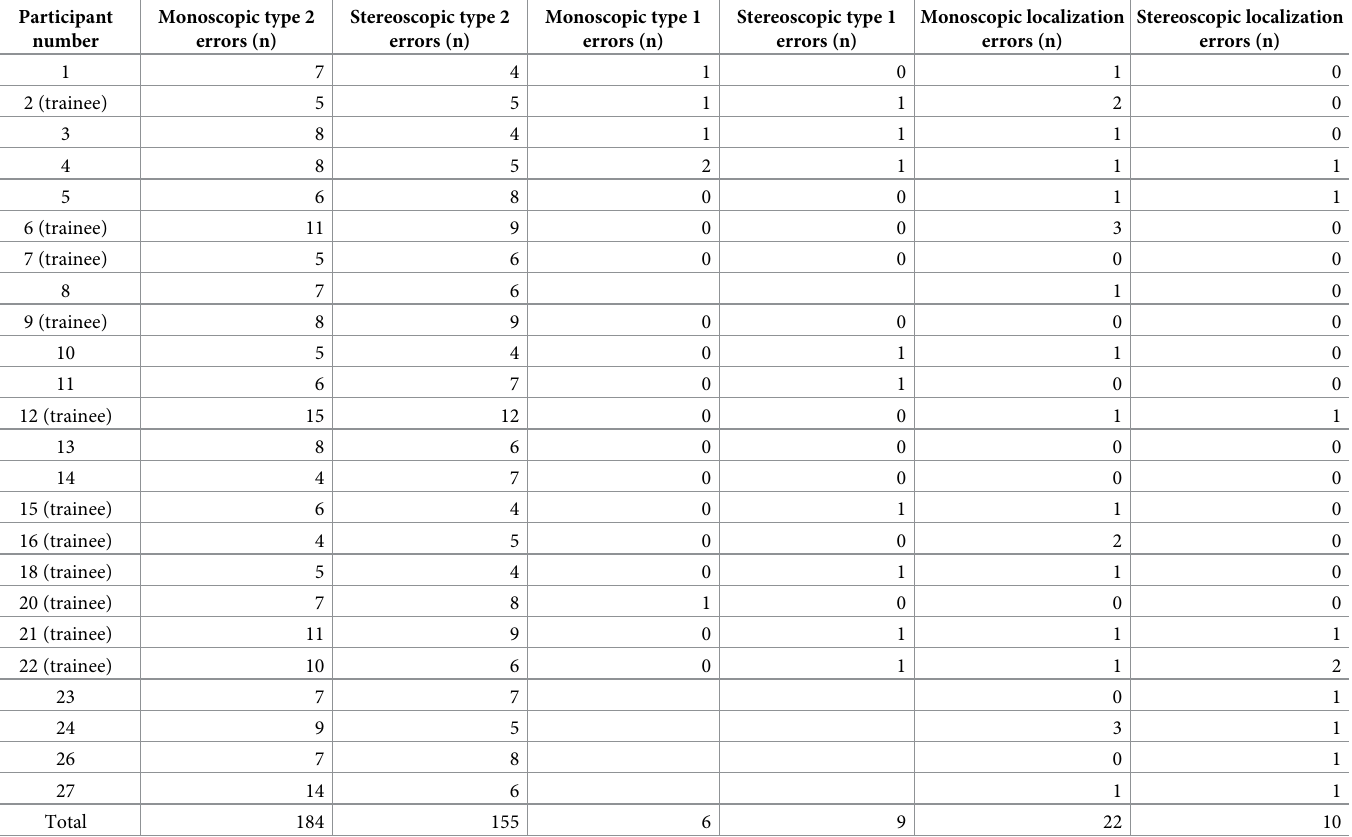
Table 2. Errors in identifying PVS and localization of veins for monoscopic and stereoscopic images for complex scans with 3 or more PVS lesions.